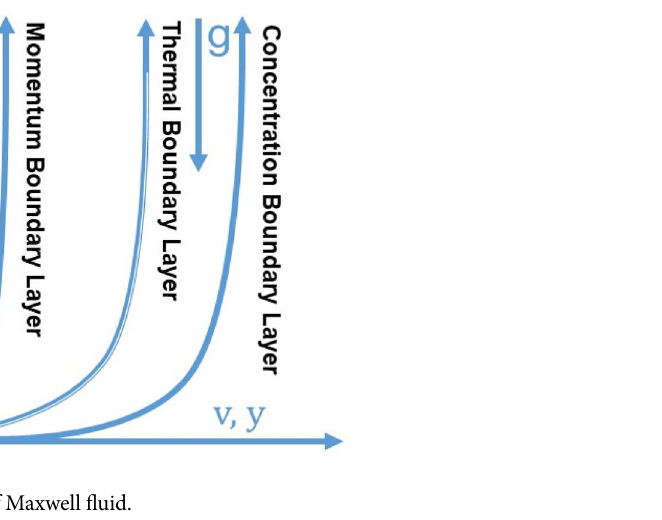
Figure 1. Flow pattern of Maxwell